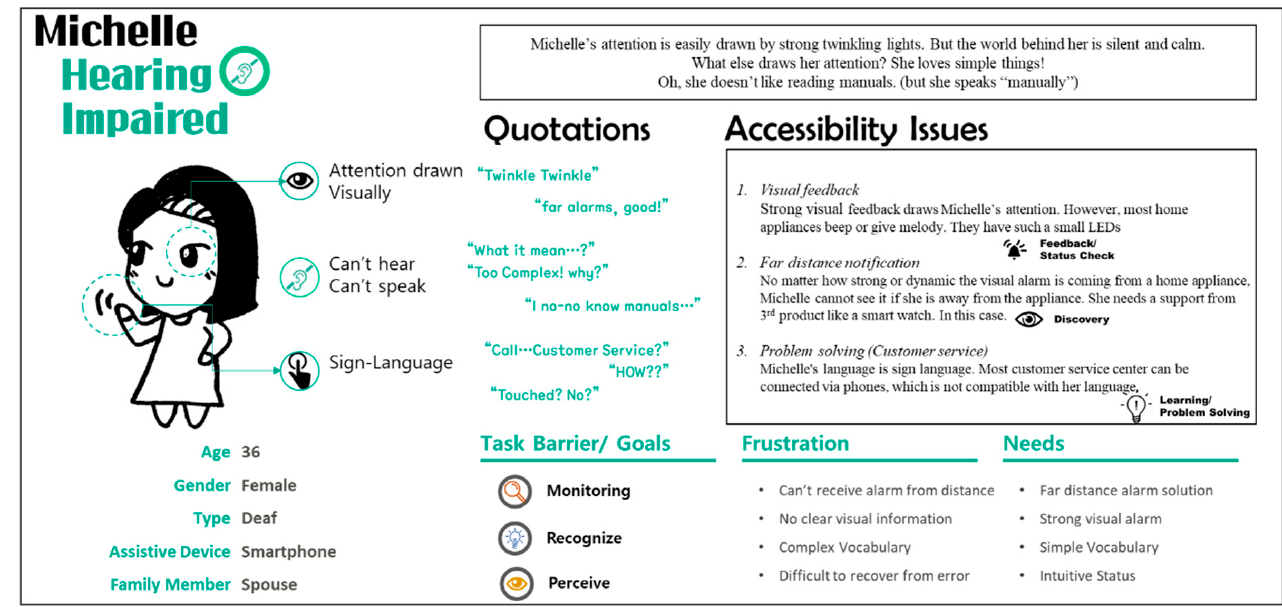
Figure A3. Persona card of Michelle, the deaf persona.